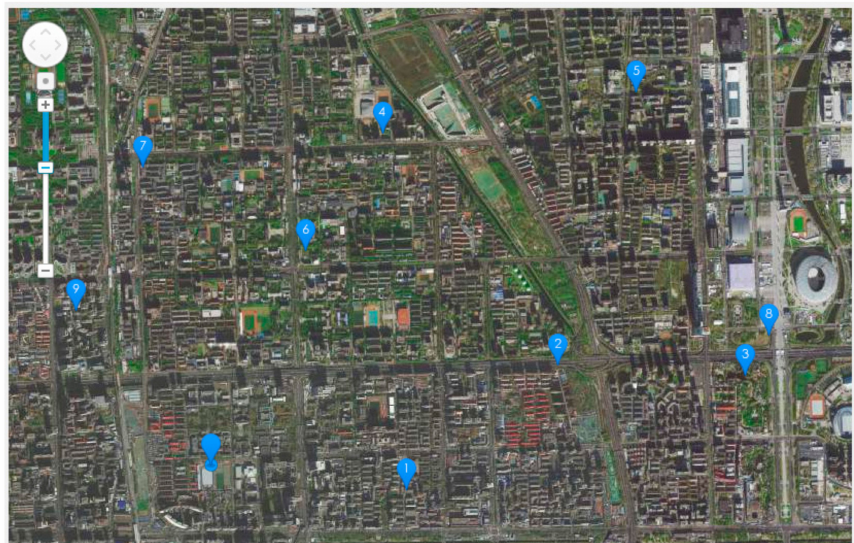
Figure 8. Representative HSA, Zeppelin NT airship adopted in the simulation study and validation.